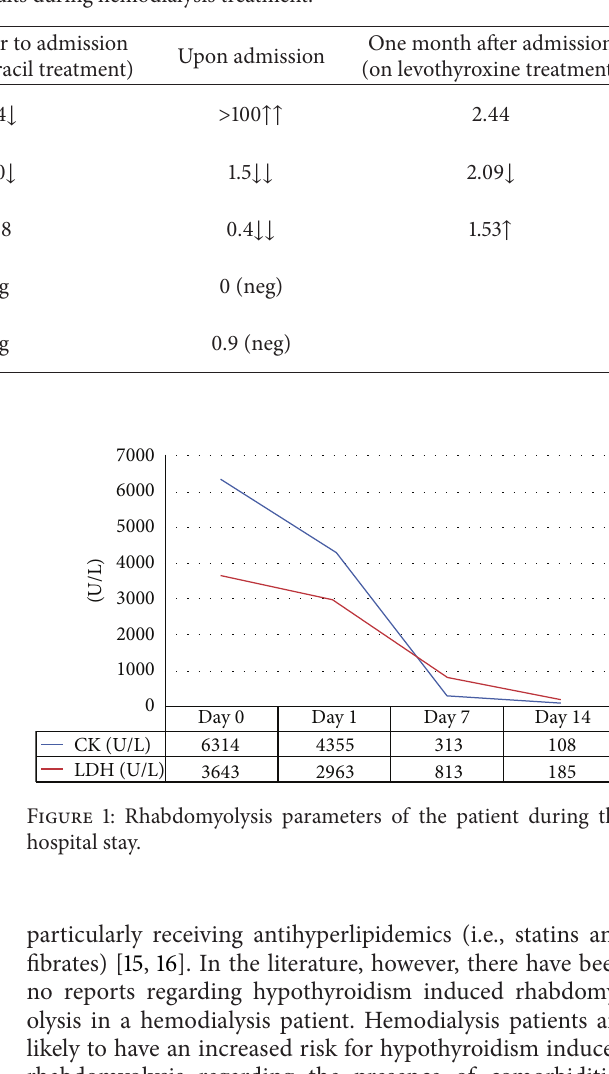
Table 1: Thyroid function test results during hemodialysis treatment.